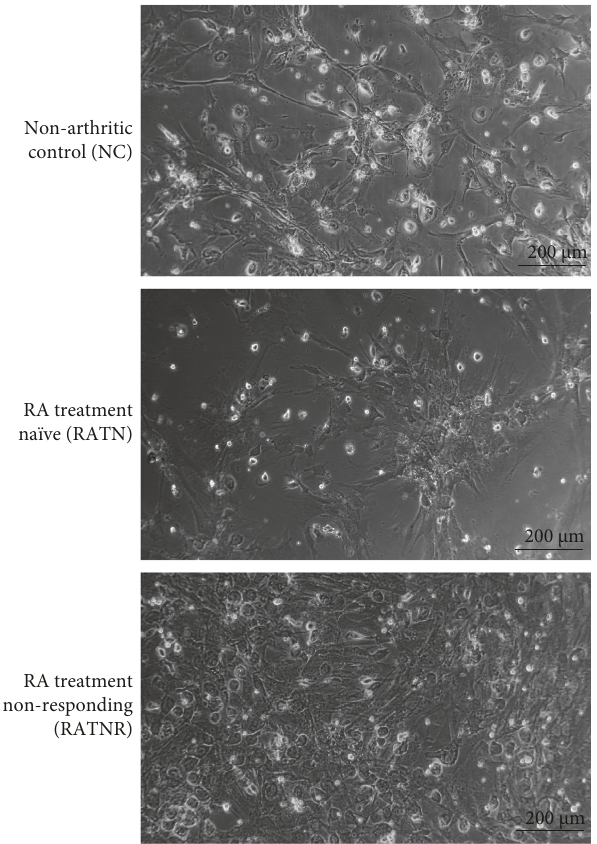
Figure 4: Representative images of the triple cell culture model indicating examples of the different observed responses to the patient serum. Images taken at 100x magnification. The scale bar represents 200 μ m.